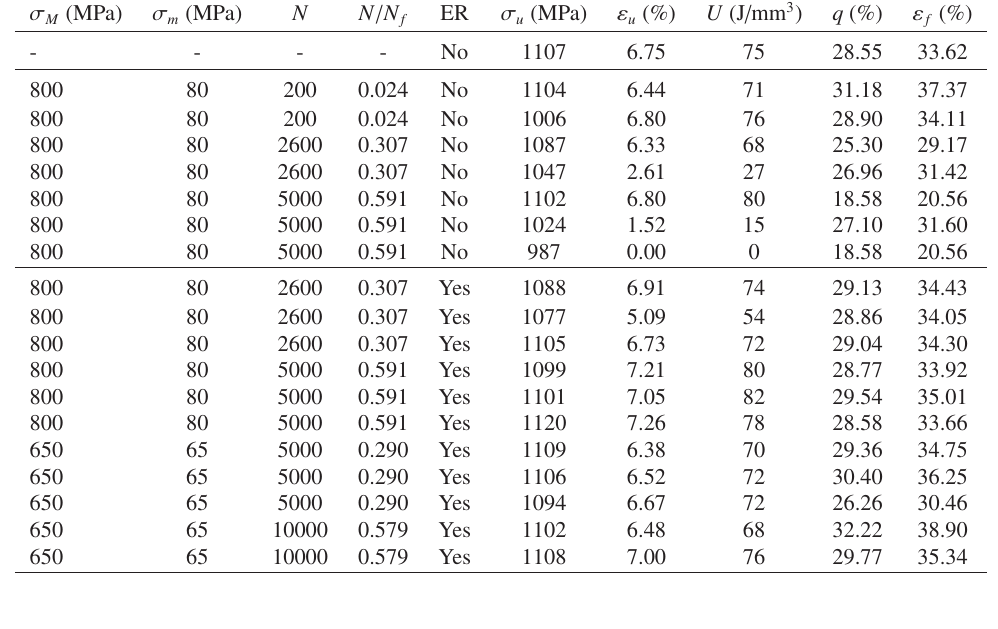
Table 2. Tensile properties at quasi-static strain rate of as-received and previously fatigued Ti-6Al-4V specimens.